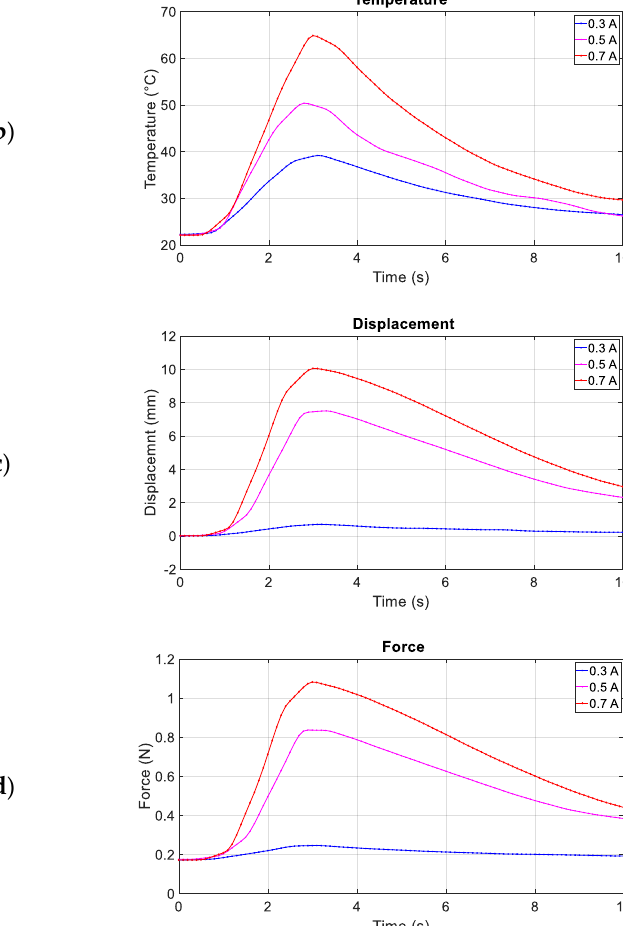
Figure 7. Results of muscle characterization. ( a ) Overall results for five cycles; ( b ) magnified temperature plot of first cycle; ( c ) magnified displacement plot and ( d ) magnified force plot. The 0.7 A pulse was able to produce the highest temperature from the Joule heating, and a corresponding high displacement and force. The 0.3 A pulse had significantly lower displacement and force output.